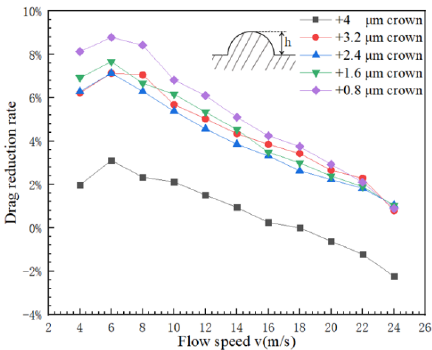
Figure 8. Relationship between the water flow velocity and the drag reduction rate of the groove surface of the positive crown with different heights.